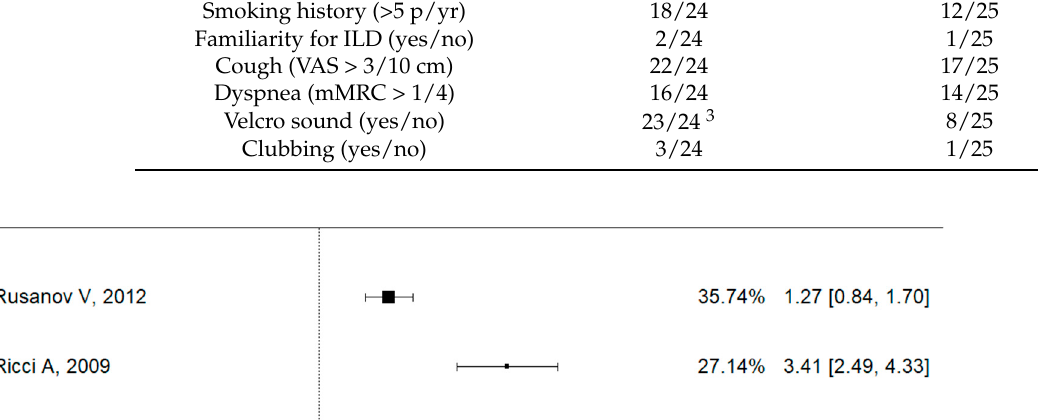
Figure 2. ( a ) Metanalysis results from Ca125 concentrations of selected studies; ( b ) metanalysis results from CEA concentrations of selected studies.